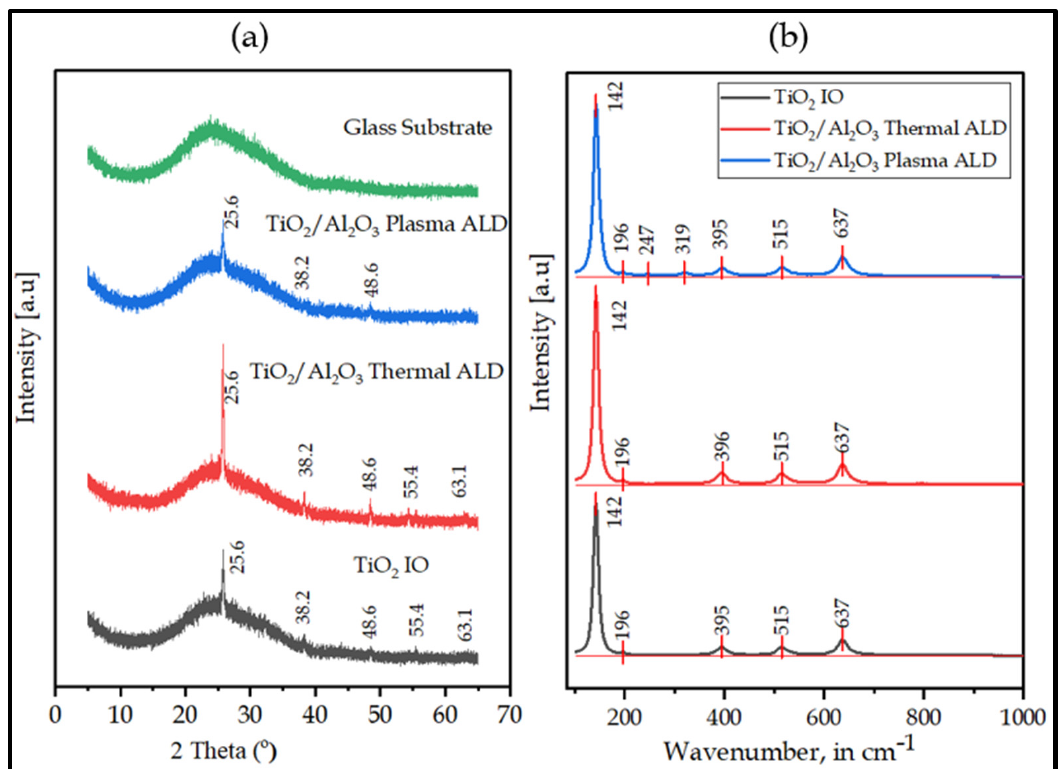
Figure 4. ( a ) XRD; ( b ) Raman Spectroscopy .